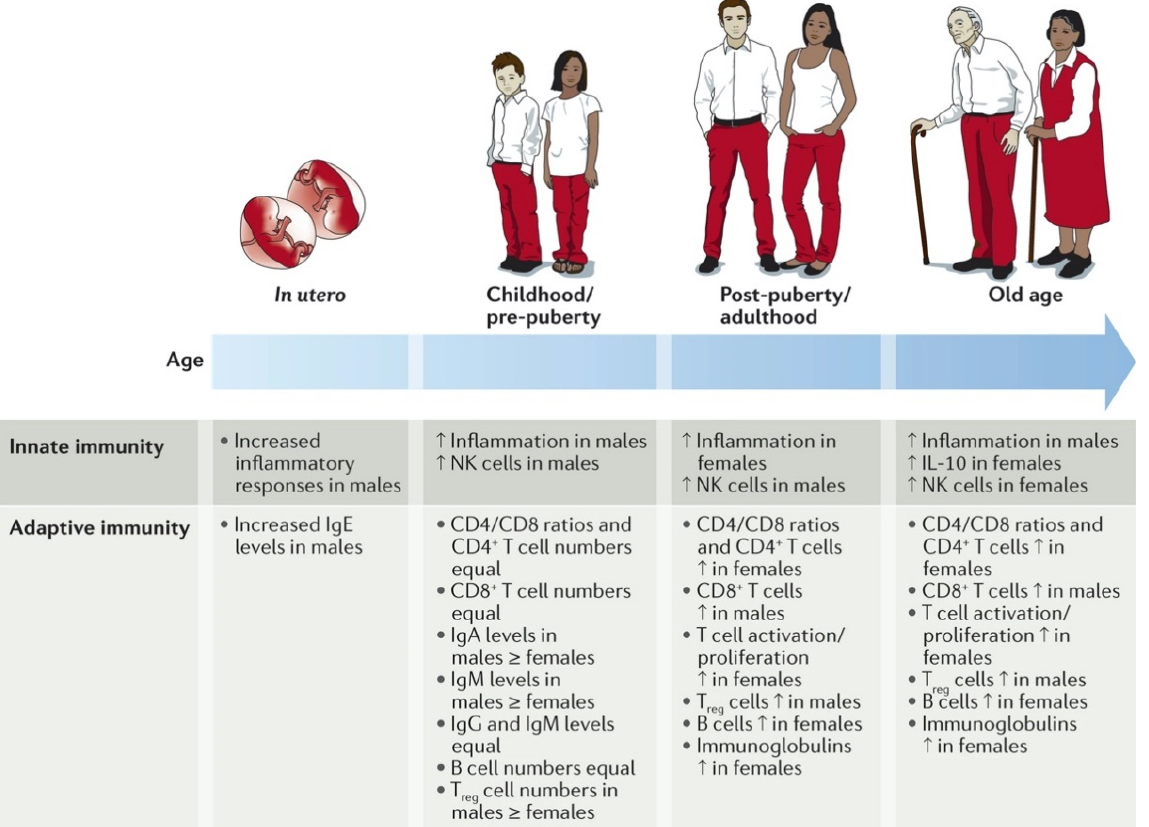
Figure 1. Gender-specific differences in immune responses and inflammatory diseases. Multiple immunological factors vary between the sexes throughout the course of life. For certain factors (for example, pro-inflammatory responses), the sex differences change at puberty and then wane in later life, suggesting hormonal effects. For other factors, the sex difference remains constant from birth to old age (for example, higher numbers of CD4 + T cells and CD4/CD8 T cell ratios in females). The paucity of studies in this area is notable, particularly in utero sex differences in which results are conflicting. IL-10, interleukin-10; NK, natural killer; T reg , regulatory T. Reproduced with permission from [26] .